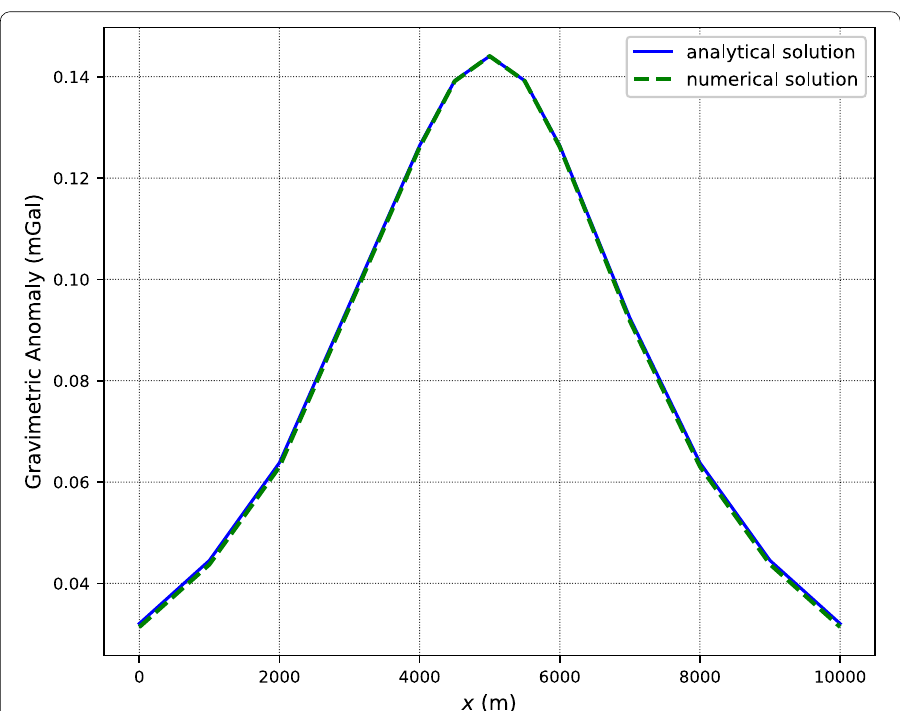
Fig. 13 Gravity anomaly profile due to a Mogi’s sphere as an excess of density about 300kg m − 3 inside a reservoir. The blue line corresponds to the analytical solution, the dotted red line to the simulated